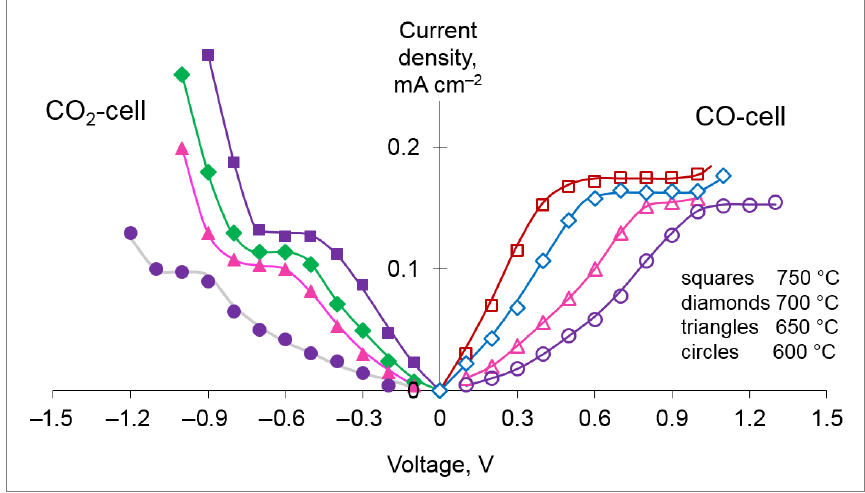
Figure 7. Current–voltage dependences of CO 2 cell (solid symbols) and CO cells (empty symbols) in dry N 2 + 4.9 vol.% CO + 4.9 vol.% CO 2 atmospheres. Error bars are smaller than the symbol size.